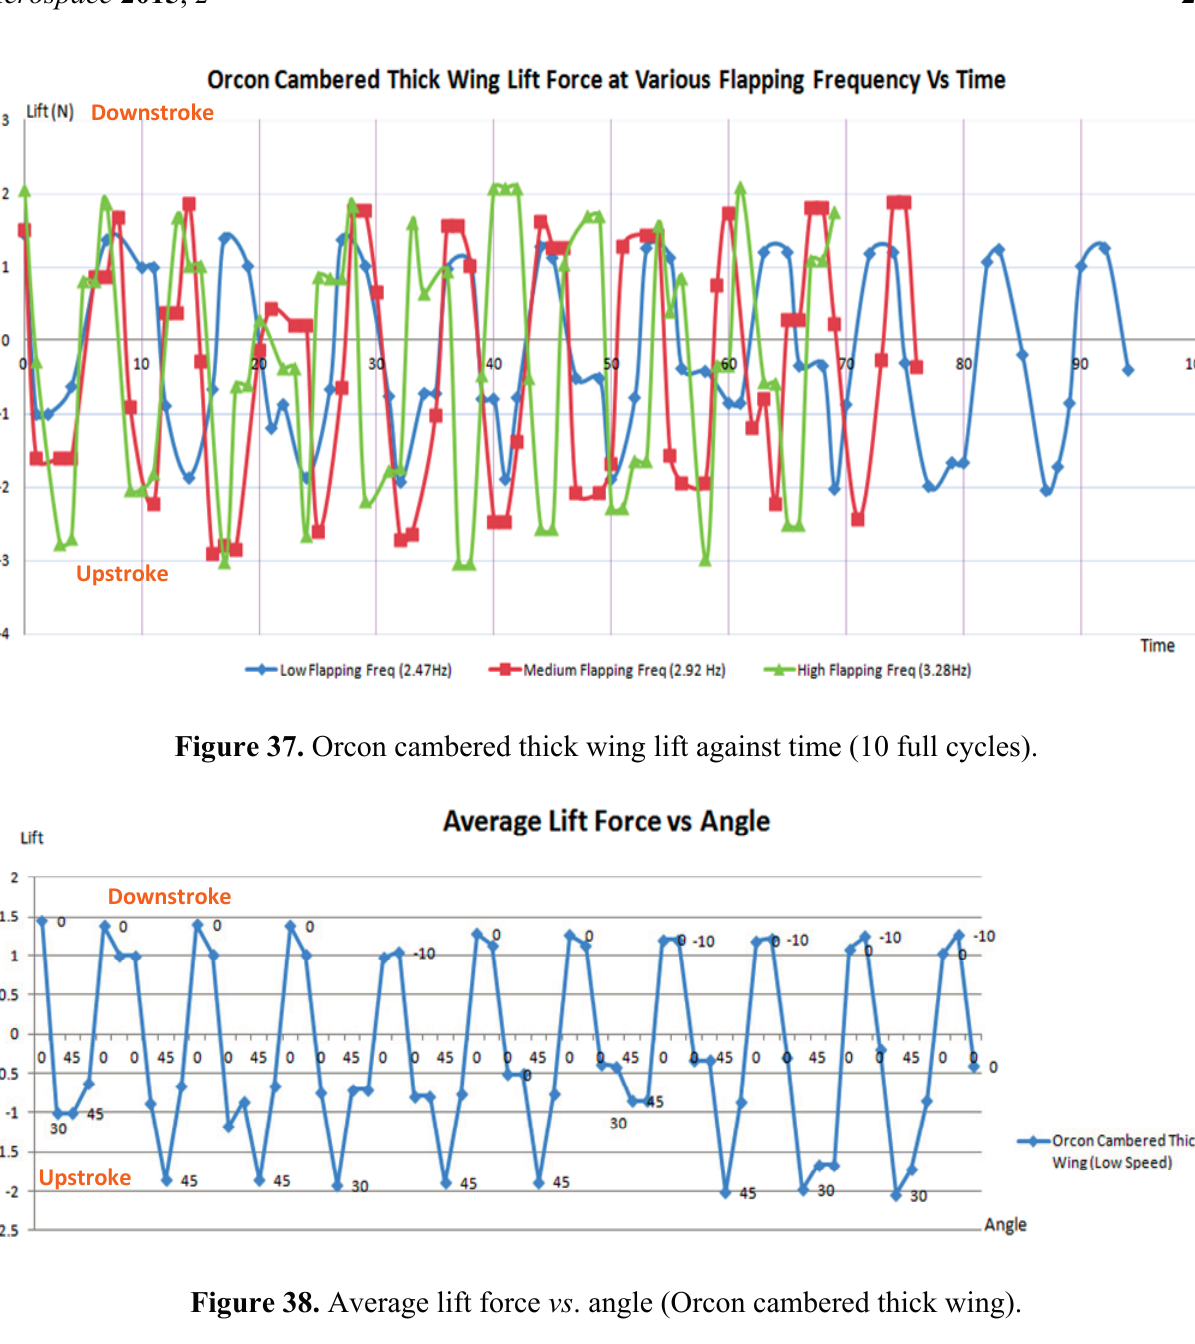
Figure 38. Average lift force vs . angle (Orcon cambered thick